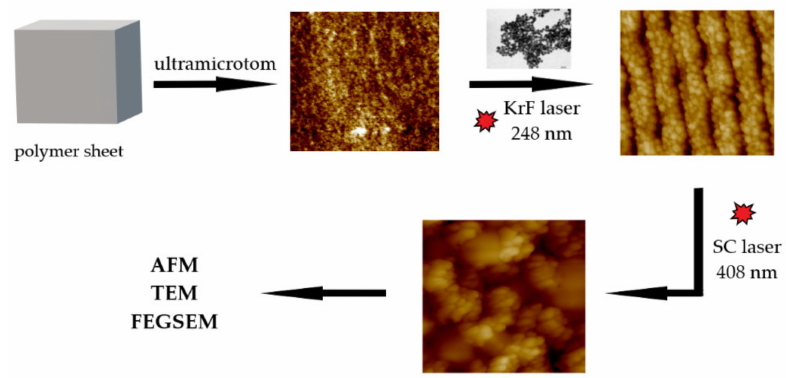
Figure 1. Schematic view of the consecutive steps during sample